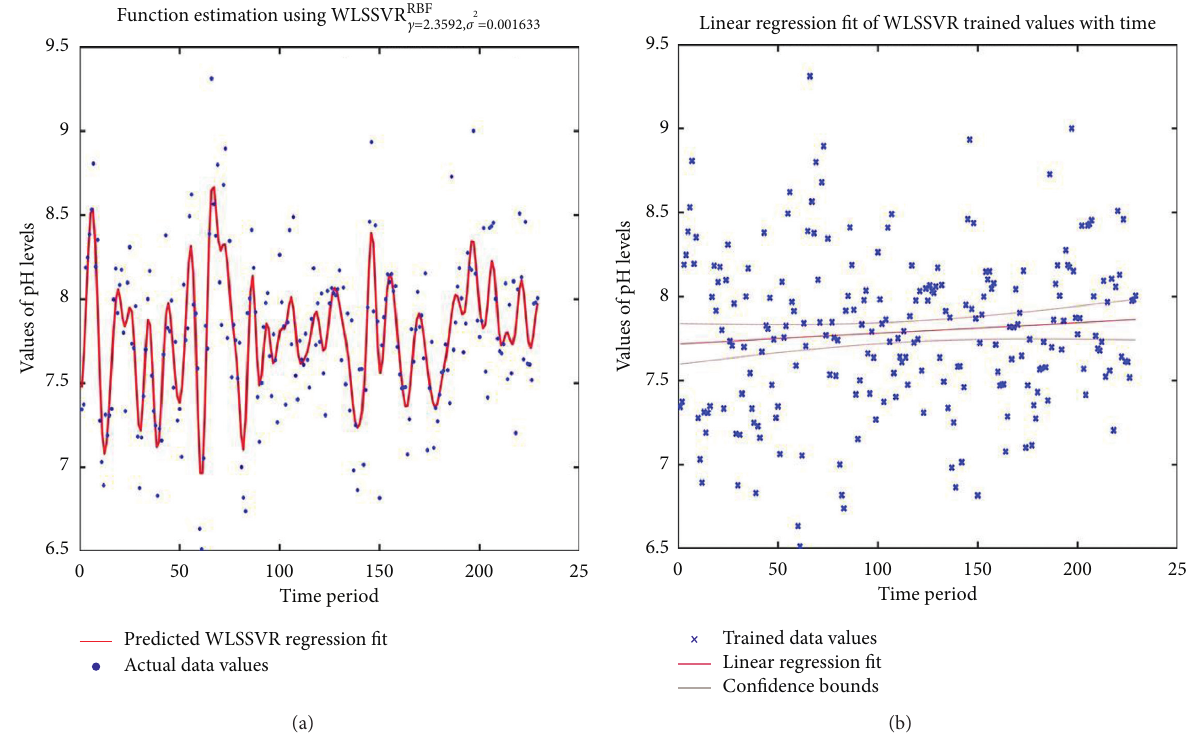
Figure 9: (a) WLSSVR regression fit of pH values at Palla. (b) Linear regression fit of WLSSVR trained pH values at Palla.